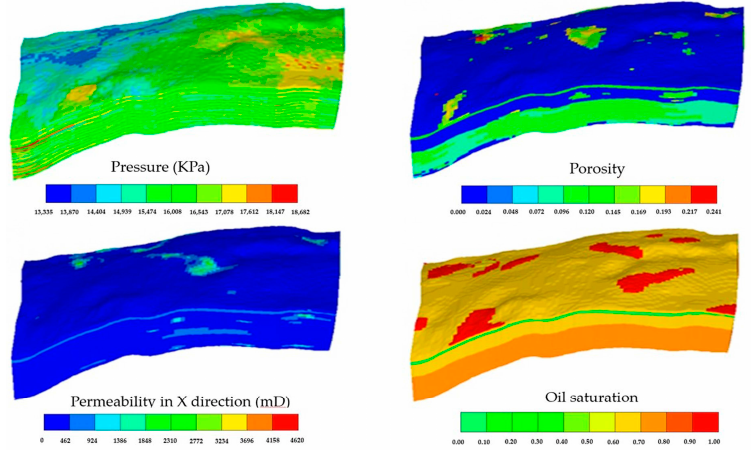
Figure 12. The distribution of initial pressure, porosity, permeability, and oil saturation in the model of the conglomerate reservoir in the Xinjiang A Oilfield.